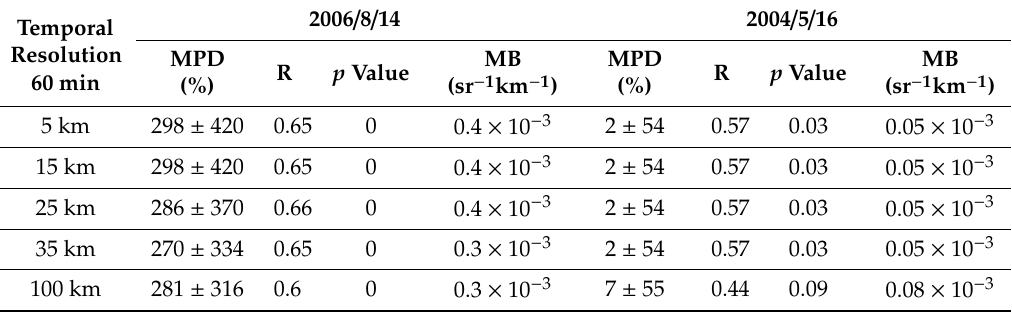
Table 2. Statistical results (MPD, MB, R, and p value) derived from simultaneous measurements between CALIOP and Harzgerode data for a cloud–free case (06 / 08 / 14) and a case with a thin cloud (04 / 05 / 16) considering di ff erent along–track averages in CALIOP data (5 km, 15 km, 25 km, 35 km, and 100